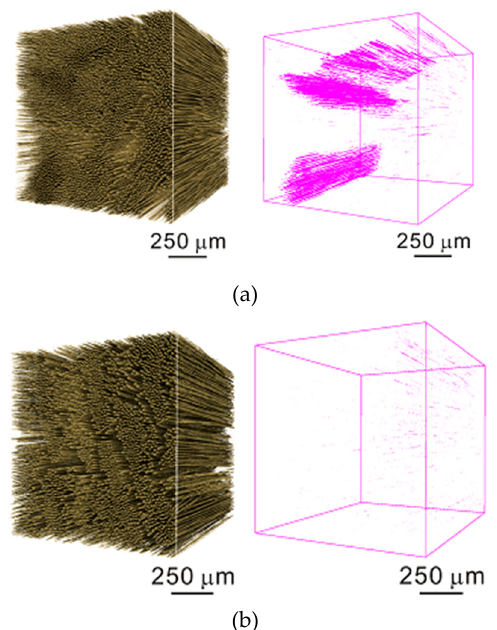
Figure 14. X-ray microscope images and extracted void images of CNF-CFRTP. ( a ) Hot press molding (HP). ( b ) Hot press mold with direct resistance heating (DRH-HP).